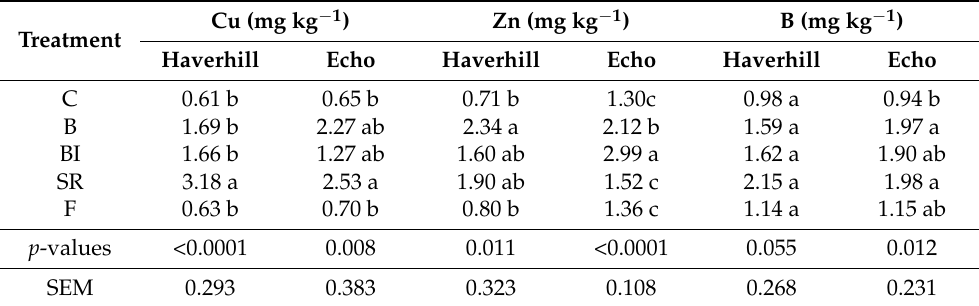
Table 4. Extractable Cu, Zn, and B in post-harvest soils (0–15 cm) from wheat, pea, and canola plots,